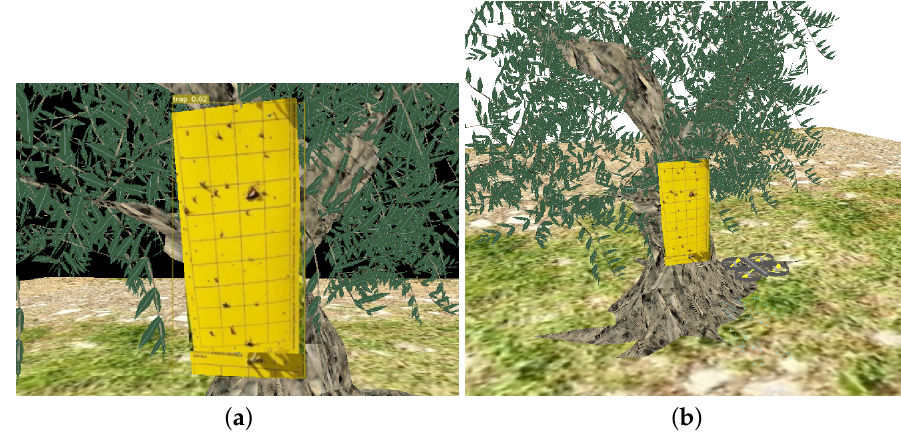
Figure 21. ( a ) UAS view when reaching the objective. ( b ) UAS position relative to the